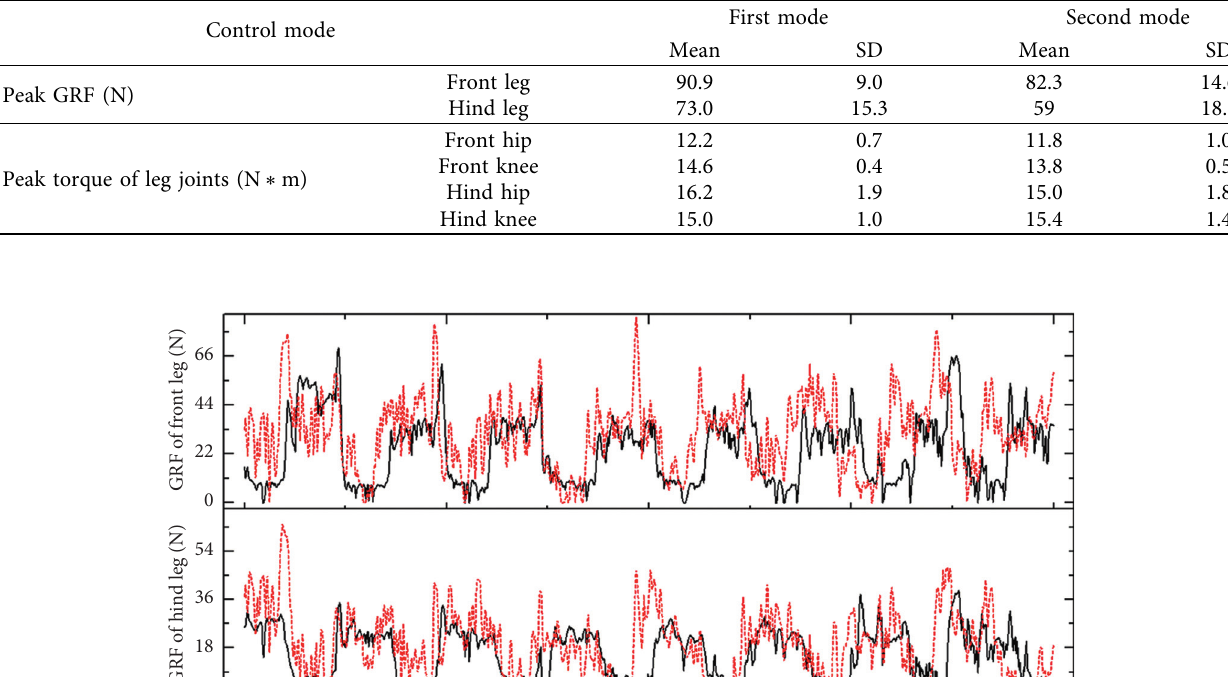
Table 2: Peak ground reaction forces and torque by two control modes.